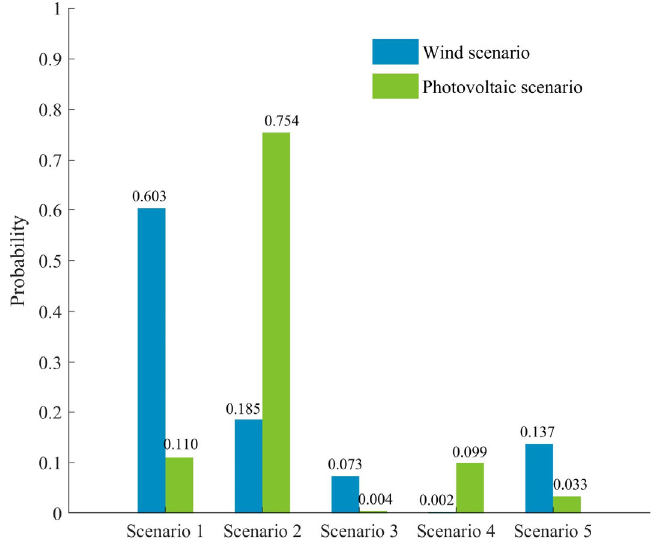
Figure 6. Typical scenario probabilities.